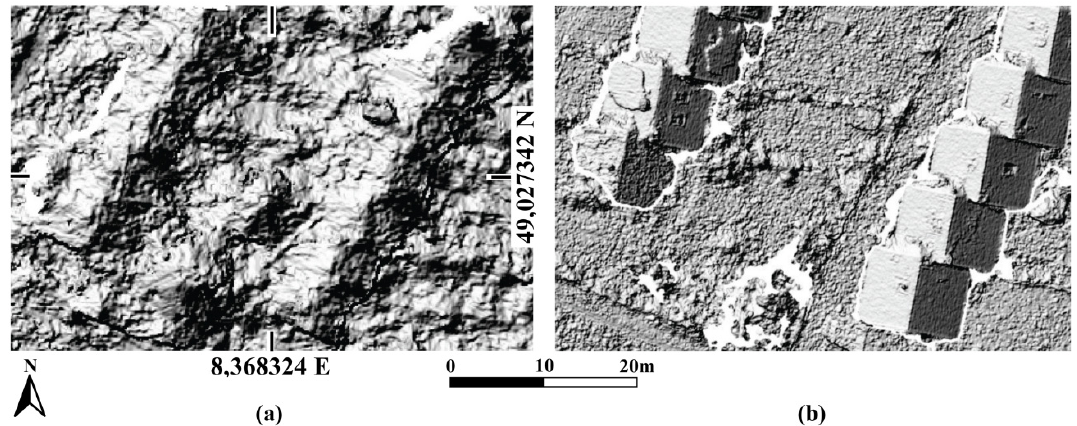
Figure 6. DSMs derived from aerial images of different resolutions (Karlsruhe test site). ( a ) DSM